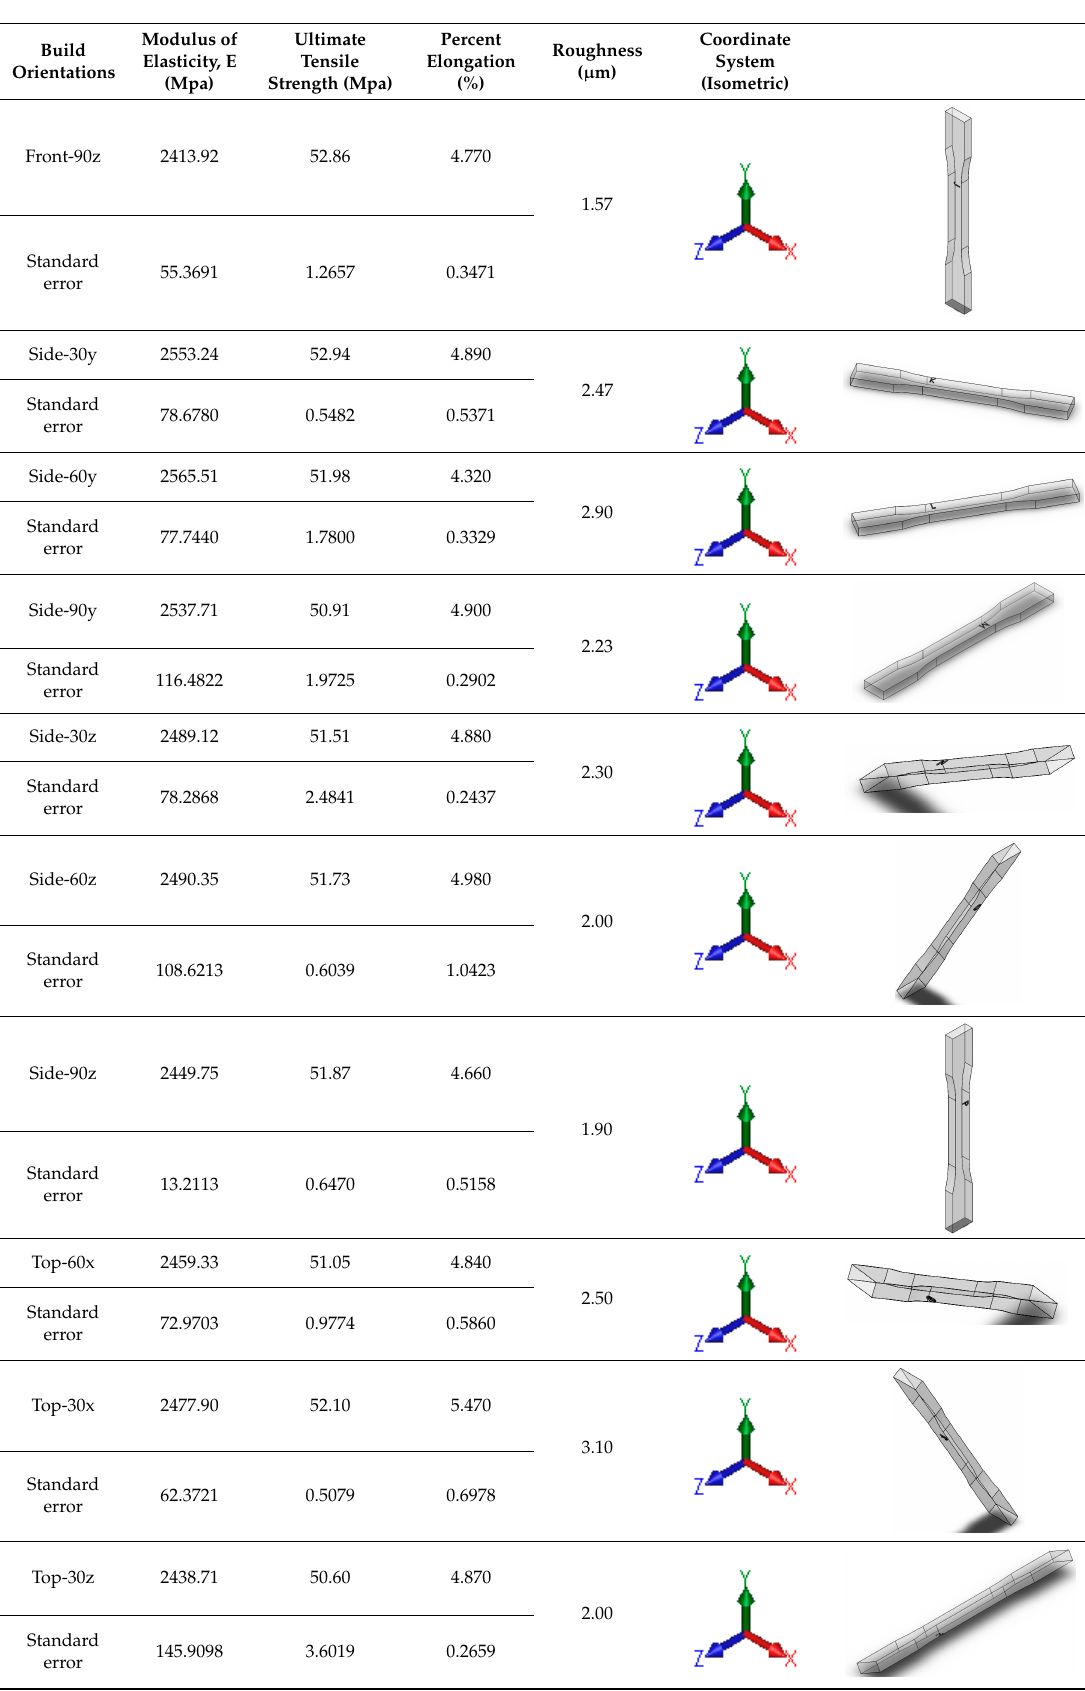
Figure 9. The mean surface roughness for the different orientations.